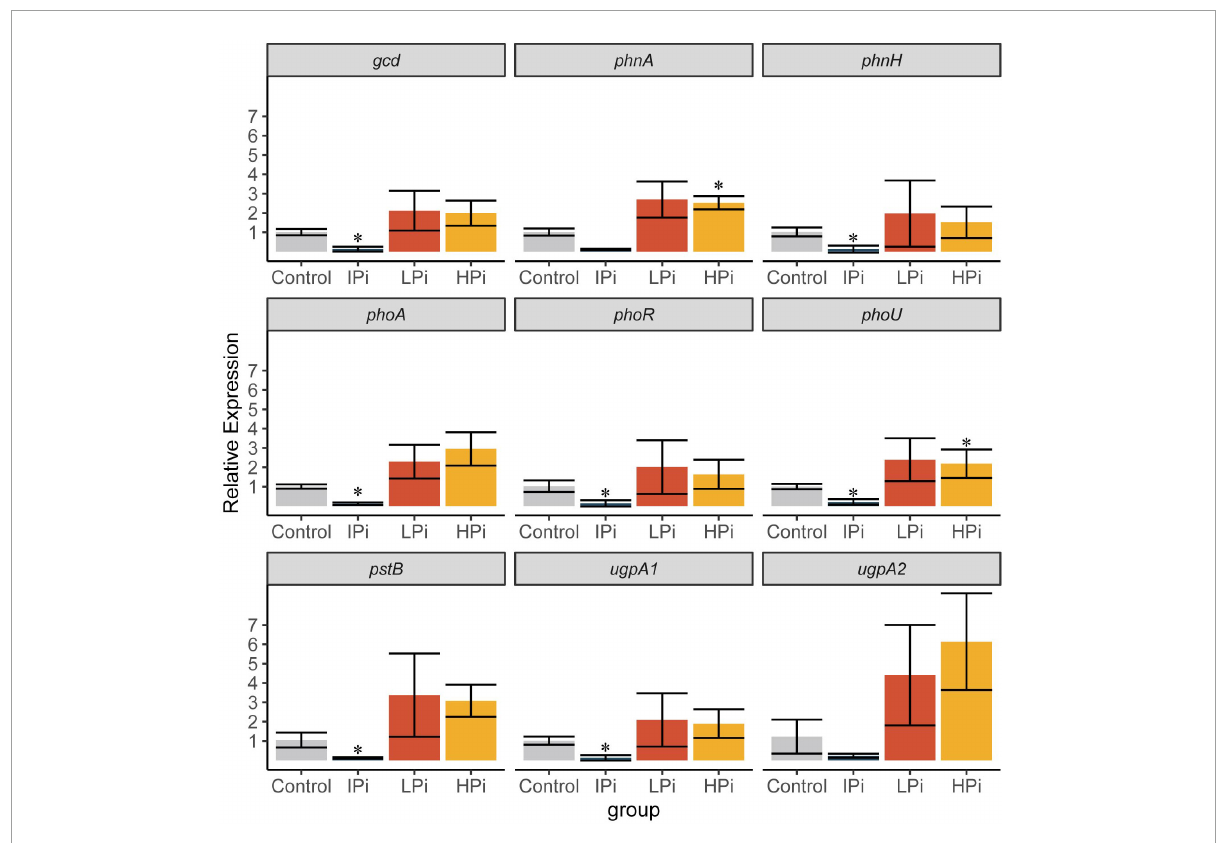
FIGURE9 Expression of phosphate-related genes. Mean ± SD values of 2 − (cid:49)(cid:49) Ct are shown ( n = 3). IPi, YMB with 10 g · L − 1 of Ca 3 (PO 4 ) 2 ; LPi, YMB with 5 mmol · L − 1 of K 2 HPO 4 ; HPi, YMB with 10 mmol · L − 1 of K 2 HPO 4 . Control was YMB. ∗ P < 0.05 compared with the control